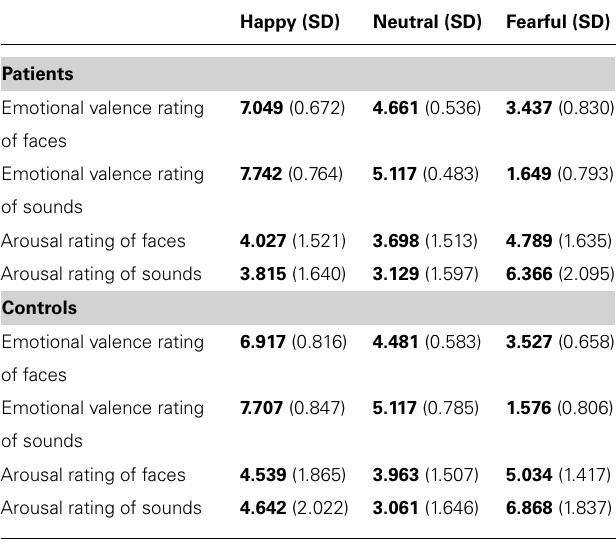
( F 4,77 = 0.96, p = 0.437). To further analyze the significant inter- action between sound × group post hoc t -tests were calculated (all results are Bonferroni-corrected for multiple comparisons). We found no significant global differences (across all types of con- currently presented faces) between groups, neither in the happy, nor neutral, nor fearful sound condition (faces paired with happy sounds: T 80 = − 0.065, p = 0.948; faces paired with neutral sounds: T 80 = 0.861, p = 0.392; faces paired with fearful sounds: T 80 = 0.602, p = 0.549). However, the post hoc tests demonstrated that while in healthy controls there was no difference in the rating Table 4 | Mean values and SD for emotional valence and arousal of faces when concurrently hearing happy compared to neutral ratings of faces and sounds. sounds ( T 40 = − 0.08, p = 0.939), patients with depression rated faces as more fearful when presented with happy compared to neu- Happy (SD) Neutral (SD) Fearful (SD) tral sounds ( T 40 = 4.61, p < 0.001). Furthermore, in controls the ratings of faces differed between the happy and fearful sound con- dition ( T 40 = − 3.36, p = 0.002), whereas there was no difference between these two conditions in the patient group ( T 40 = − 1.28,